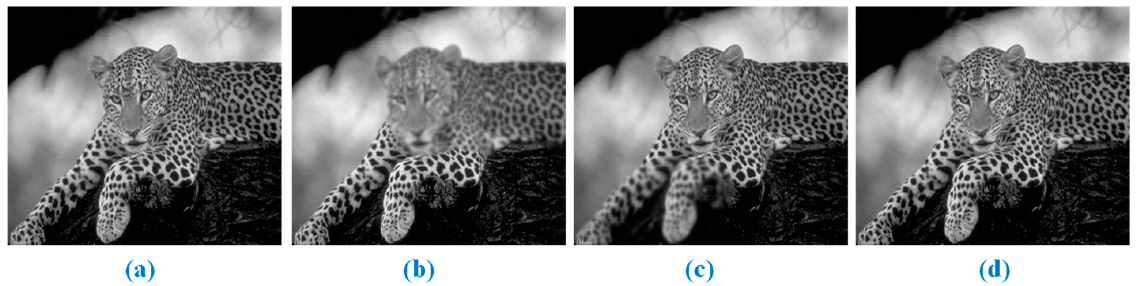
Figure 4. (Balloon): ( a ) Original Image; ( b , c ) Multi-focus input images; ( d ) Proposed fusion.